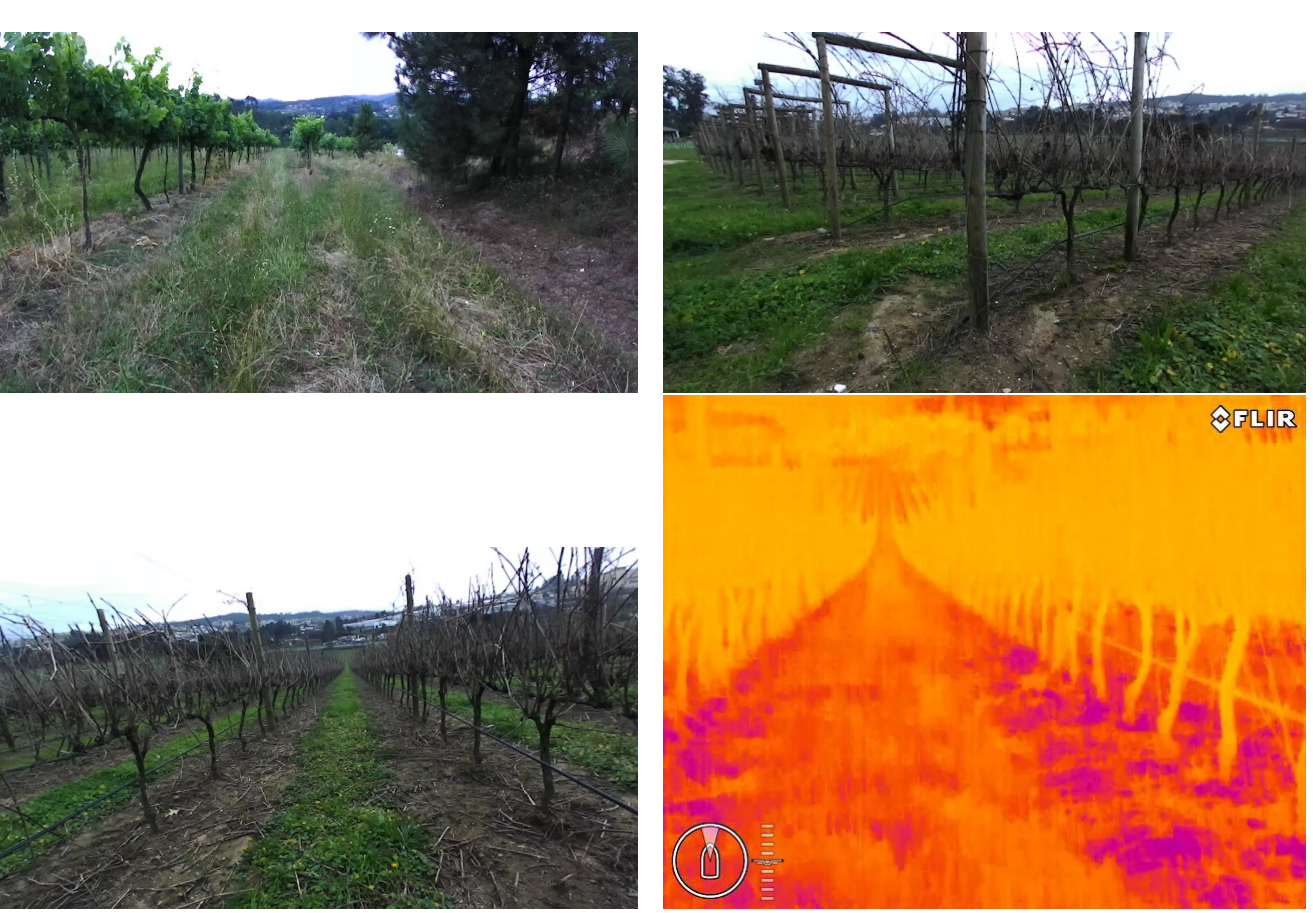
Figure 1. An example of the variety of images in the